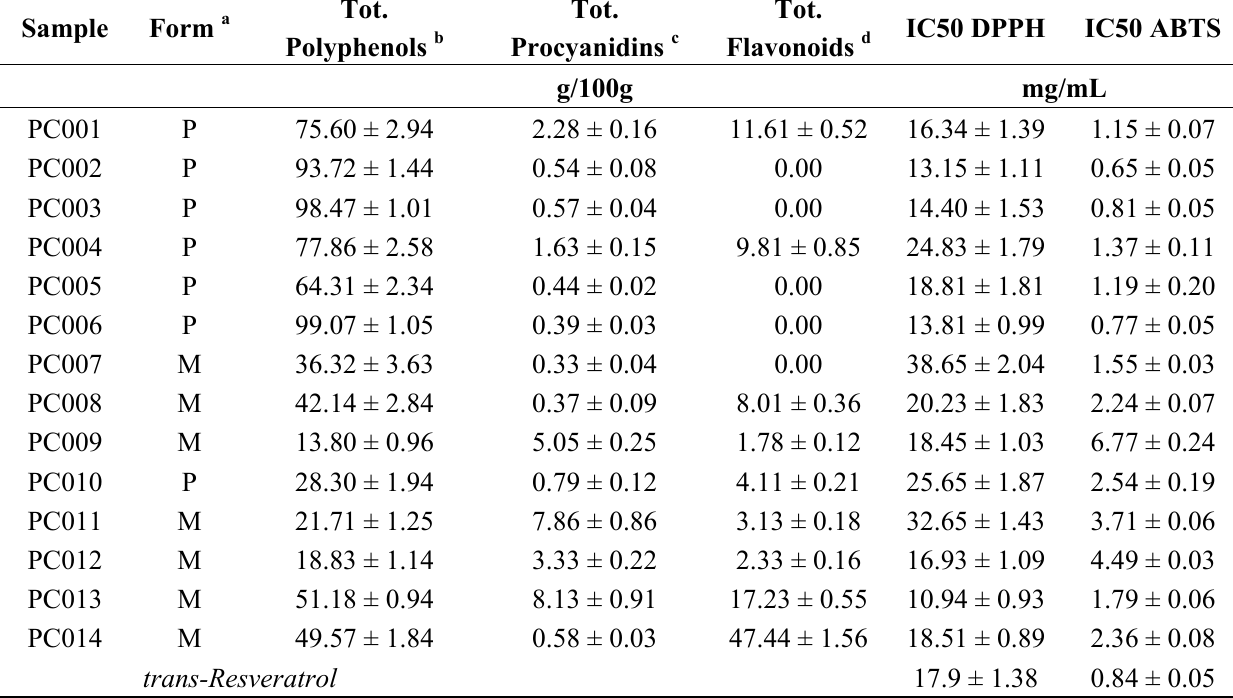
Table 3. Total polyphenols, procyanidins, flavonoids and antioxidant properties of 14 resveratrol-containing food supplements.